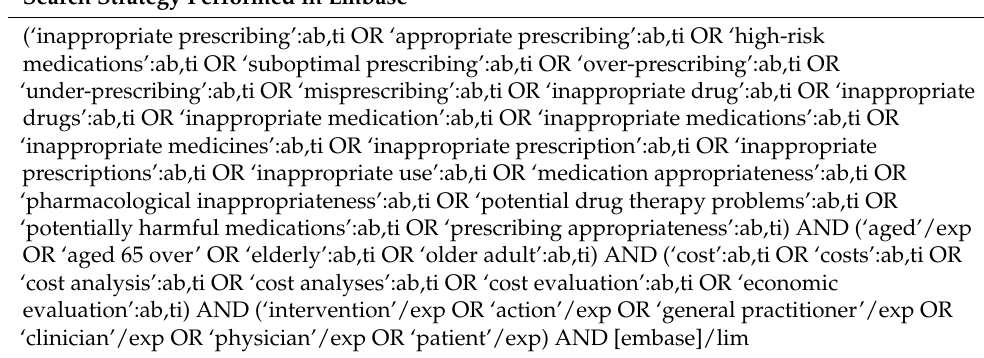
Table A1. Cont. Search Strategy Performed in Embase